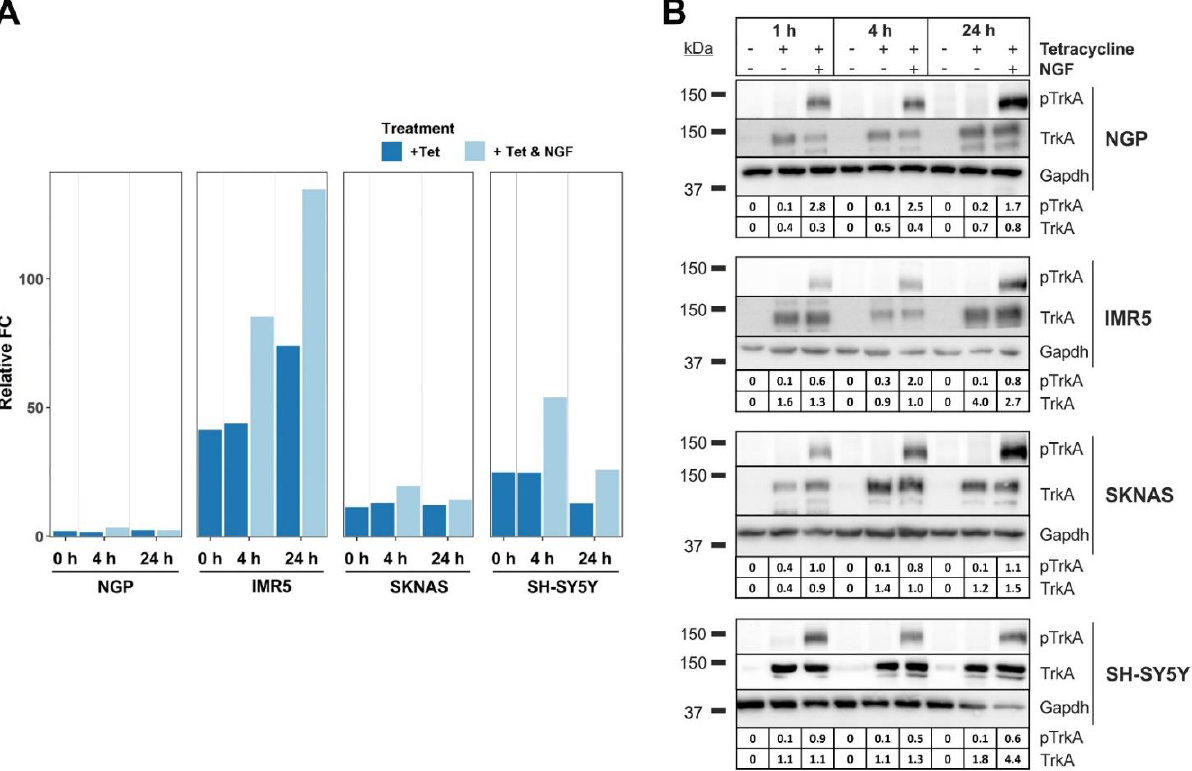
Figure 2 . Validation of inducible expression and activation of NTRK1 in four neuroblastoma cell lines. ( A ) NTRK1 expres- sion was verified in the NTRK1-negative cell lines NGP, IMR5, SKNAS and SH-SY5Y using qPCR at time points indicated.